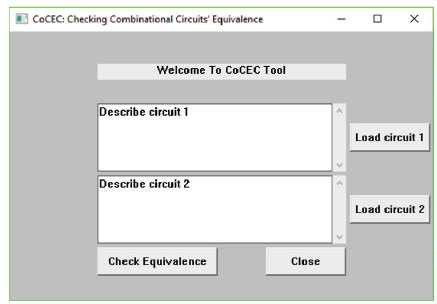
Figure 10: User interface of